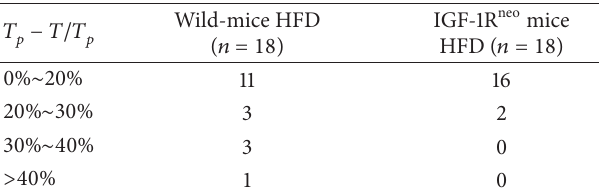
Table1:Gradeanalysisofthepass-throughtimeofmiceinthewater maze Automatic Control System test.